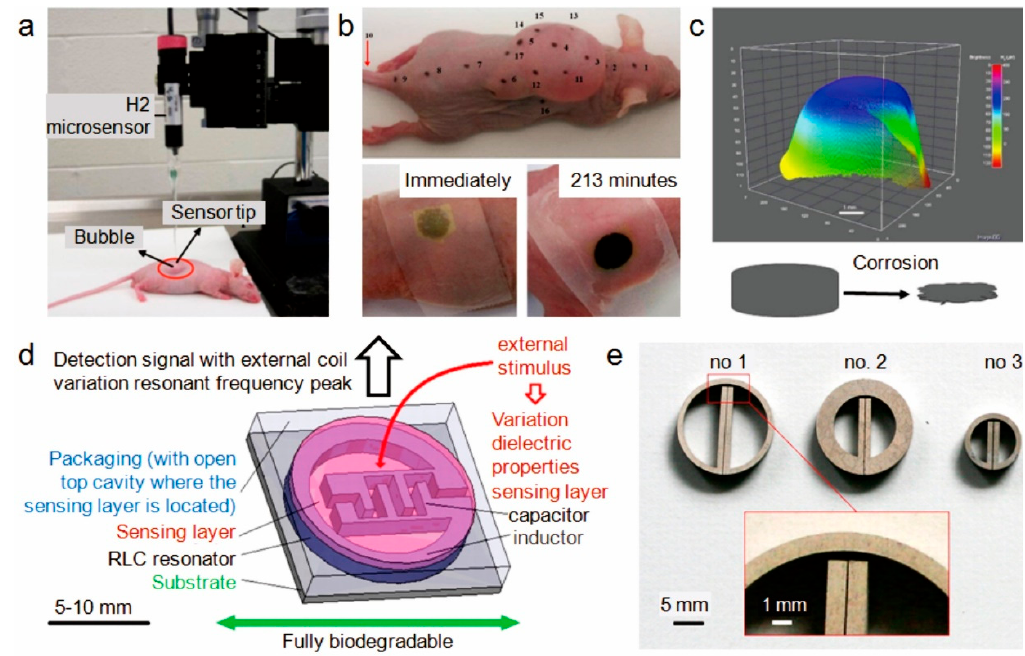
Figure 7. Sensor-based corrosion monitoring system: ( a ) hydrogen micro-sensor assembled on a micromanipulator for measuring hydrogen transdermally from a Mg alloy implanted subcutaneously in a mouse where the sensor tip is in a direct contact with the mouse skin; ( b ) photograph of an anaesthetized nude mouse with marked measurement points, and color development of thin film visual hydrogen sensor at two different observation times; ( c ) 3D reconstruction of the brightness change in the hydrogen sensor area at 213 min and associated volume change of the Mg implant; ( d ) design of a fully biodegradable sensor (wireless telemetry with inductive link); ( e ) resistor–inductor–capacitor (RLC) resonators made of absorbable materials. Adapted with permission from Elsevier and Springer Nature [72,74,75].